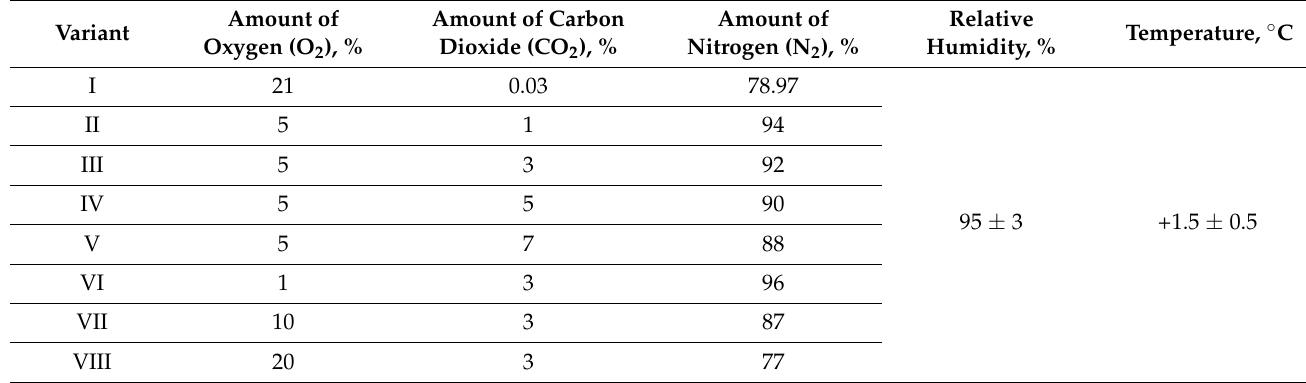
Table 1. Composition of controlled atmosphere in